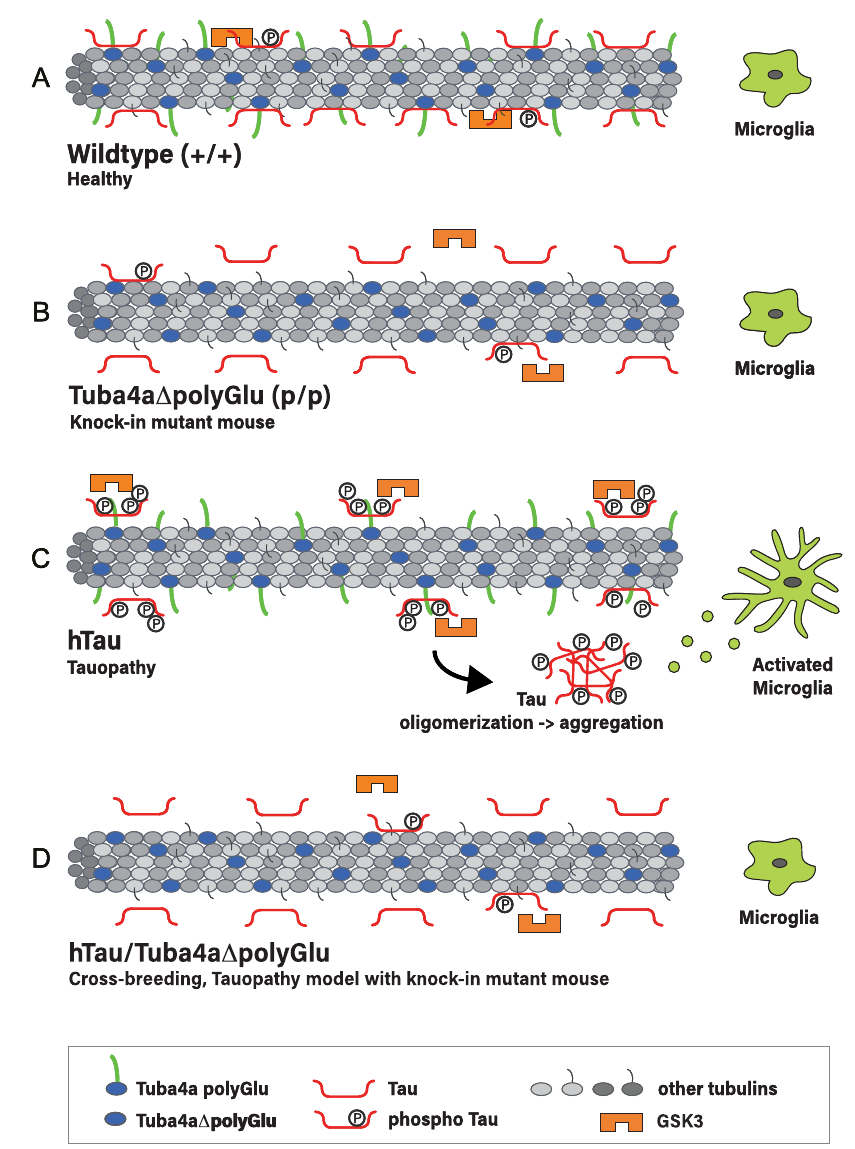
Fig. 10 Model. A In healthy wild-type neurons, tubulin C-termini are posttranslationally modi fi ed through polyglutamylation (tails). Tau binds to microtubules and can be phosphorylated by the kinase GSK3. B The knock-in mutant mouse (Tuba4a Δ polyGlu), generated in this study, lacks polyglutamylation (green tails in A ), speci fi cally at tubulin alpha-4 (Tuba4, blue). Mutant mice are characterized by reduced Tau and GSK3 binding to microtubules. C The tauopathy mouse model hTau is characterized by hyper-phosphorylated Tau that detaches from microtubules, oligomerizes and subsequently forms Tau-aggregates. Neurons containing oligomerized Tau are accompanied by microglia activation, leading to gliosis and neurodegeneration (tauopathy). D Crossbreeding of hTau and Tuba4a Δ polyGlu mutant mice normalizes the disease phenotype of hTau conditions. Similar to wild-type mice, double mutants contain (i) normal phosphorylated Tau levels, (ii) normal levels of oligomerized Tau and (iii) normal microglia activation patterns. These data suggest that polyglutamylation is a critical parameter in the etiology of